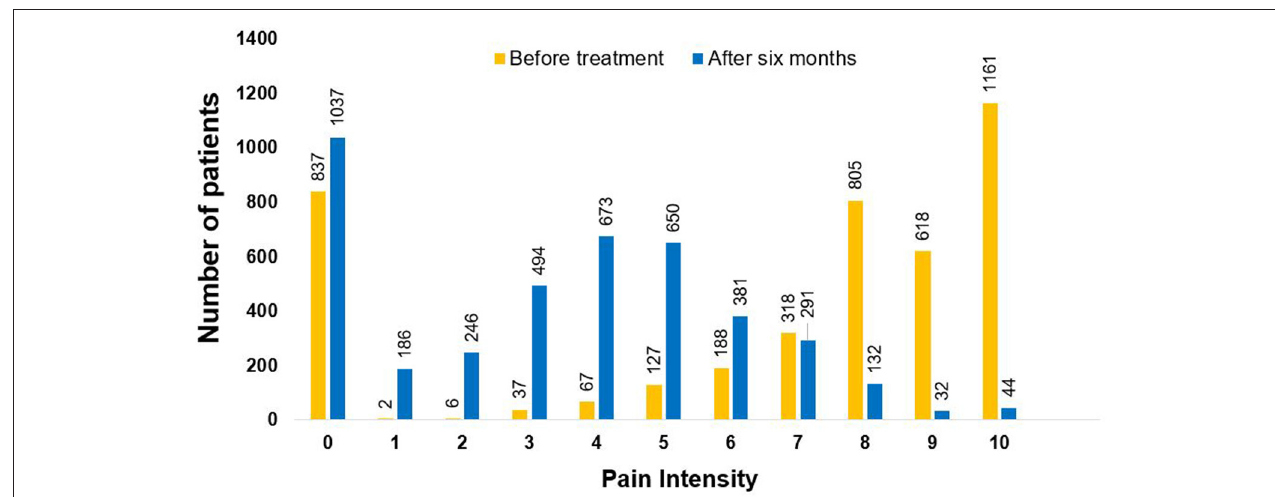
FIGURE 2 | Assessment of pain intensity. Pain intensity was assessed on a 0–10 scale, before and after 6 months of cannabis therapy ( p < 0.001). The assessment was made on 4,166 patients who responded to this question at the two time points. Pain level was measured on an 11-point scale (0 = no pain, 10 = worst pain